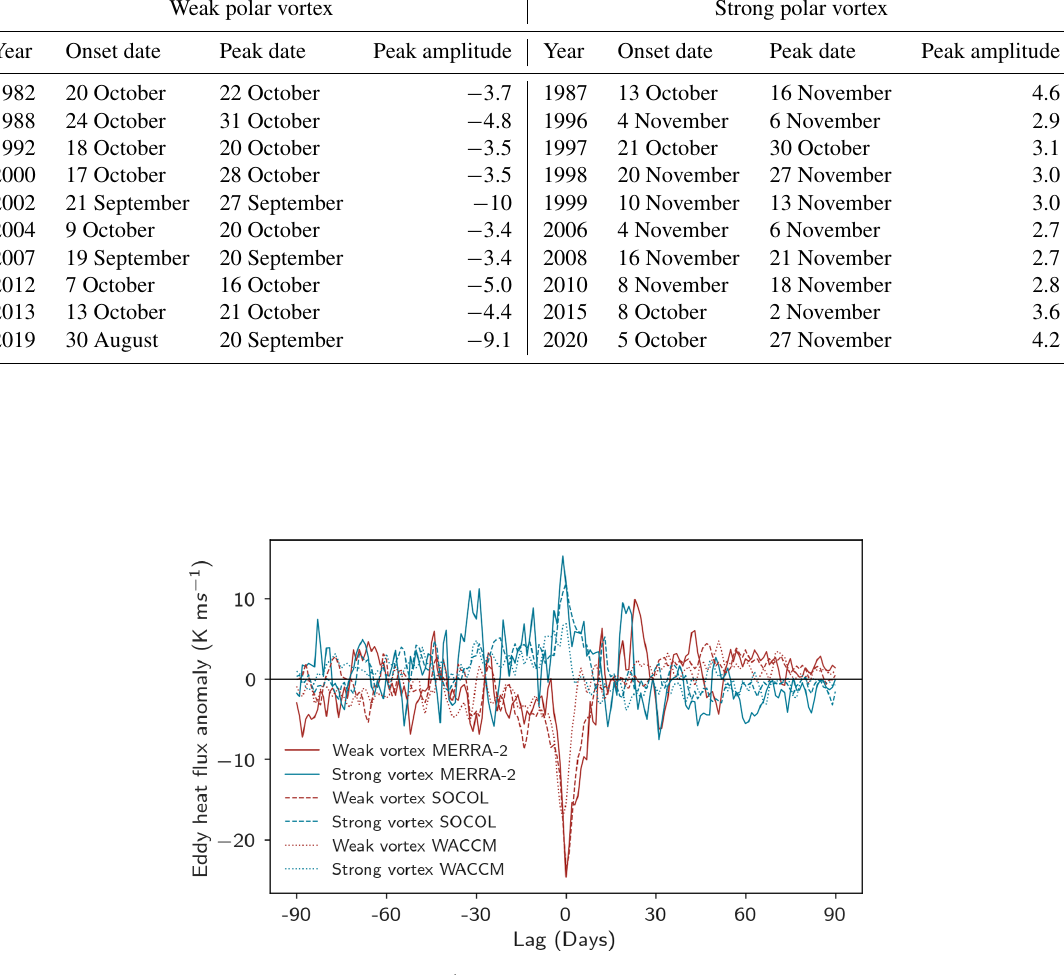
Figure A3. Composites of eddy heat flux anomalies (Kms − 1 ) averaged over 45–75 ◦ S at 100hPa for strong and weak polar vortex events for MERRA-2 and the CCMs SOCOL and WACCM. The central date (lag 0) refers to the onset day of the polar vortex